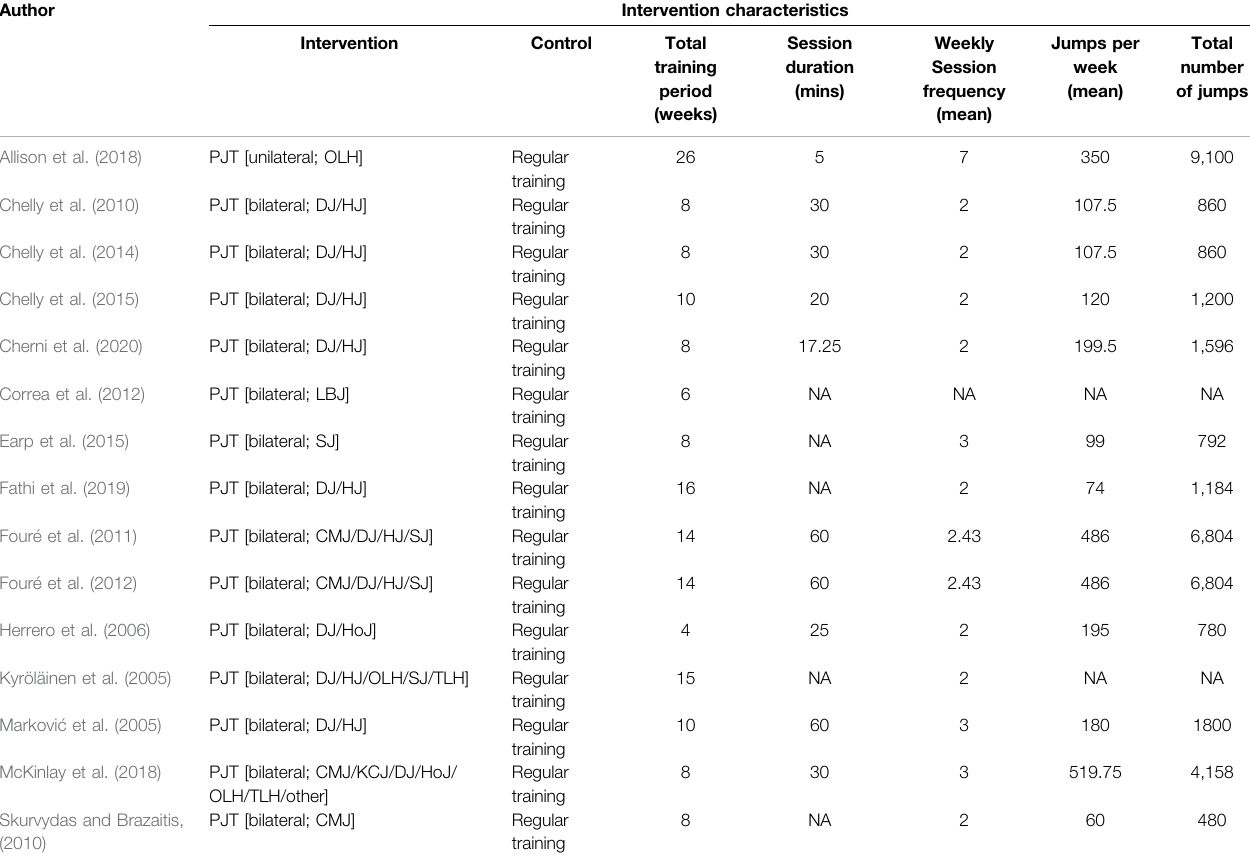
TABLE 2 | Characteristics of the plyometric jump training interventions of included